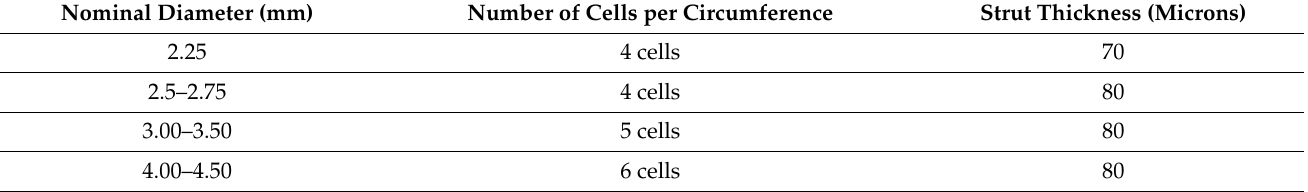
Table 1. Characteristics (number of cells, strut thickness) of Cre8 amphilimus eluting stent per stent diameter.